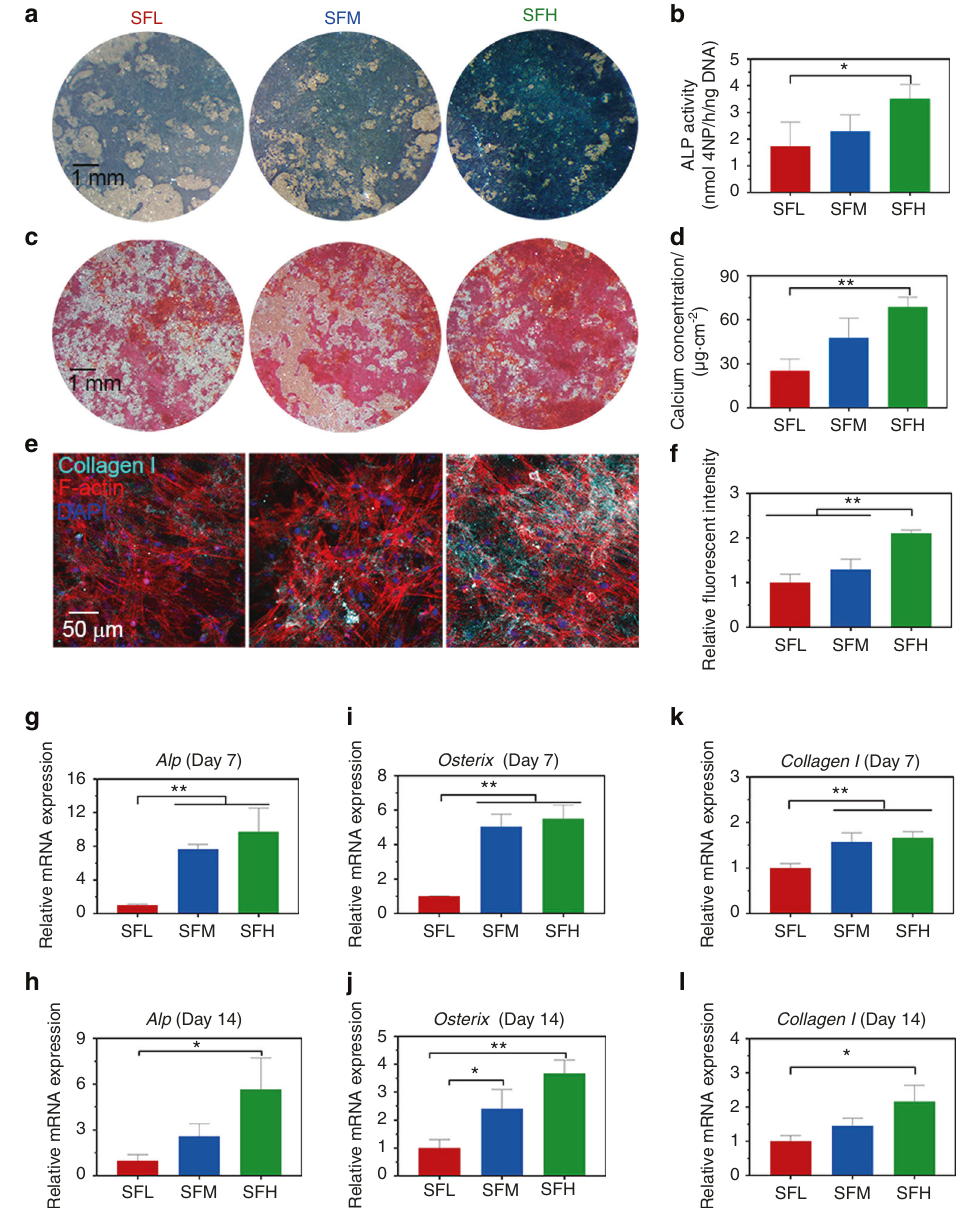
Fig. 6 Osteogenic differentiation of BMSCs on different SF substrates. a, b Images of ALP staining ( a ) and quantitative detection of ALP activity ( b ) in BMSCs at day 7. c, d Images of ARS staining ( c ) and quantitative analysis of calcium concentration ( d ) in BMSCs at day 14. e, f Immuno fl uorescence images of collagen Ι ( e ) in BMSCs and quantitative analysis of fl uorescence intensity of collagen Ι ( f ) at day 14. g – l mRNA expression levels of representative ( g – h ) Alp , ( i – j ) Osterix , and ( k – l ) collagen Ι in BMSCs at days 7 and 14. Error bars represent one standard deviation. (* P < 0.05 and ** P <